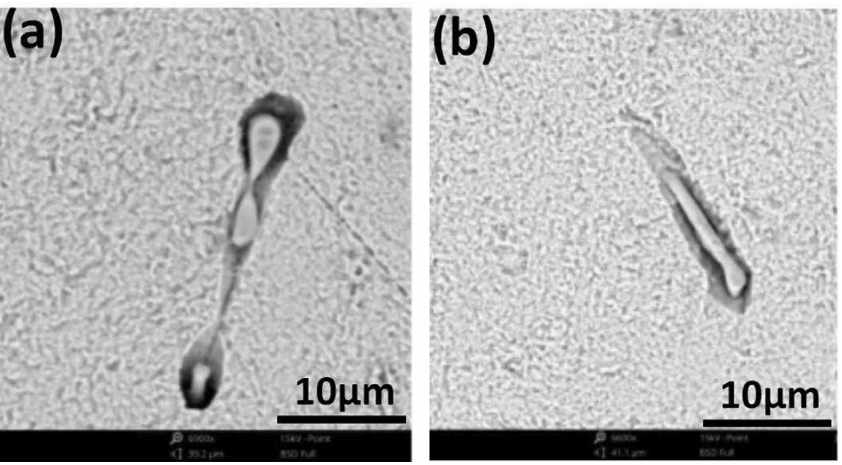
Figure 12: The corrosion morphology of the shallow MnS inclusions after 65 s of corrosion.